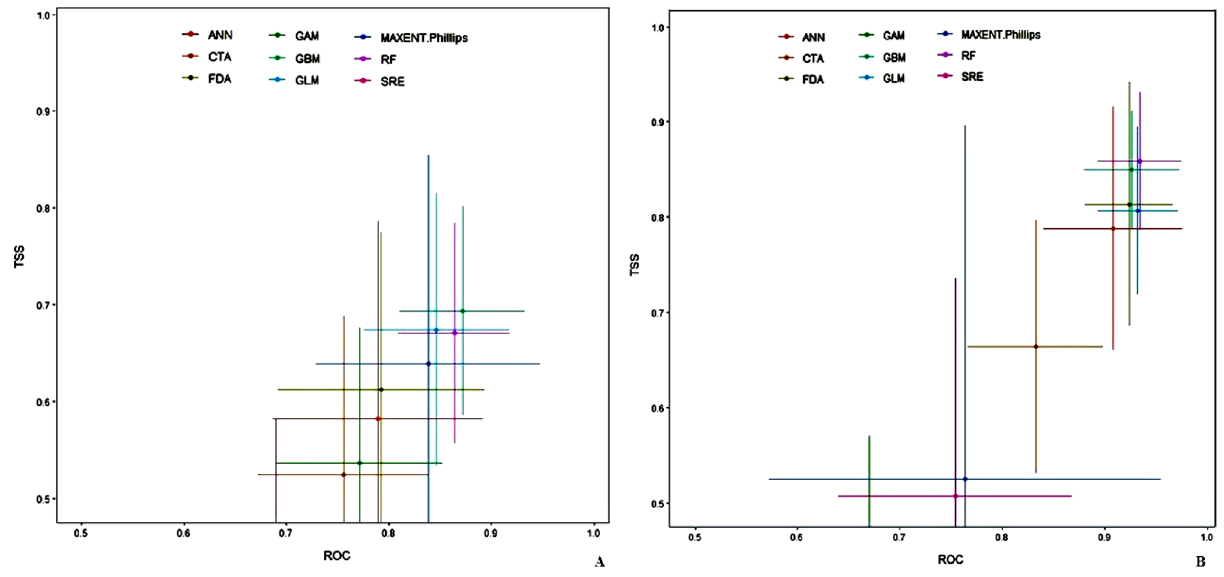
Figure 1. Mean model evaluation scores by algorithms according to two different evaluation metrics, Receivers Operating Characteristic Curve (ROC) and True Skill Statistics (TSS) for ( A ) Dactylorhiza hatageria ( B ) Rheum webbianum.